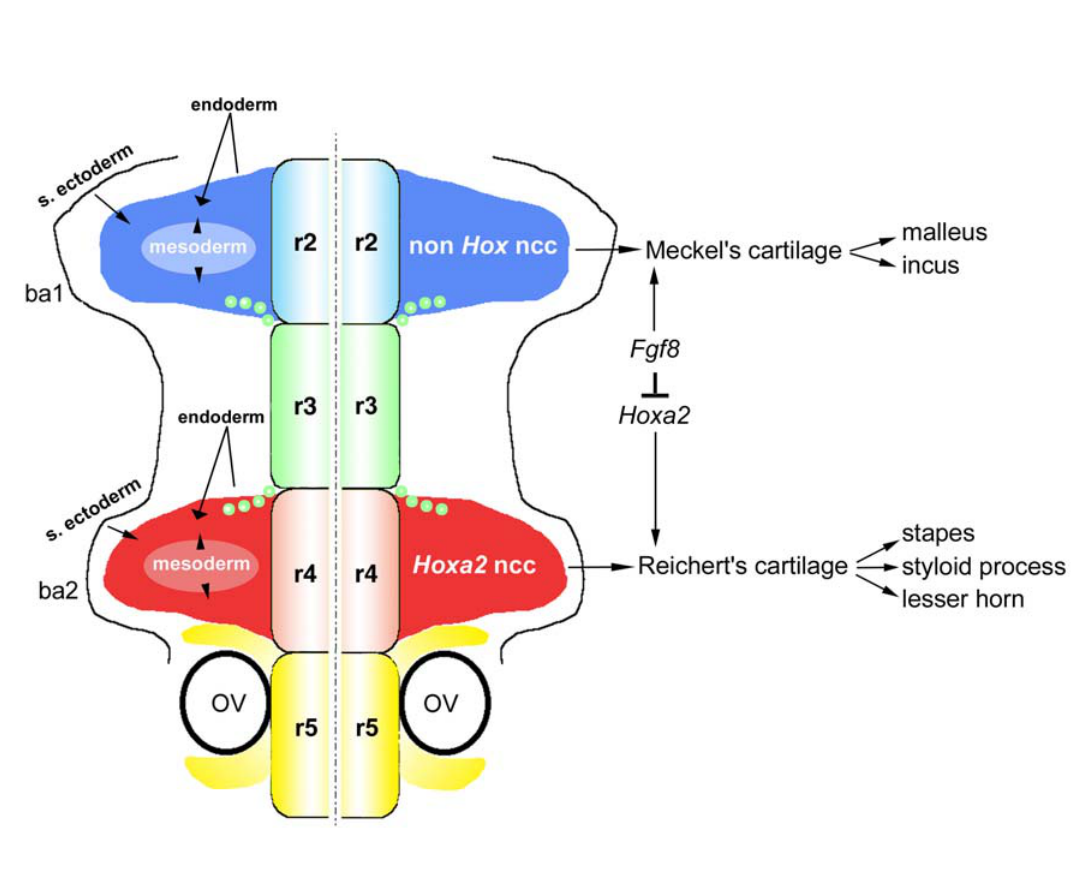
FIGURE 3 . The influence of mesoderm, ectoderm, and endoderm on the axial identity of neural crest cells and the role of Hoxa2 in second branchial arch development. The head mesoderm (red and blue ovals) plays a role in maintaining the proper domains of Hox gene expression in migrating neural crest cells (ncc), whereas the ectoderm and endoderm play roles in possibly influencing the pathways of neural crest cell migration in addition to patterning the branchial arches. The skeletal derivatives arising from the first (ba1) and second (ba2) branchial arches are listed. Hoxa2 is expressed in neural crest cells migrating into the second arch but not the first arch acts and as a selector gene that imposes the unique identity of second arch structures. In the absence of Hoxa2 , second arch derivatives are transformed into a first arch fate and similarly ectopic expression of Hoxa2 transforms first arch structures into a second arch identity. FGF8 has the capacity to repress Hoxa2 in second branchial arch neural crest cells, transforming the second arch into a first arch identity. OV, otic